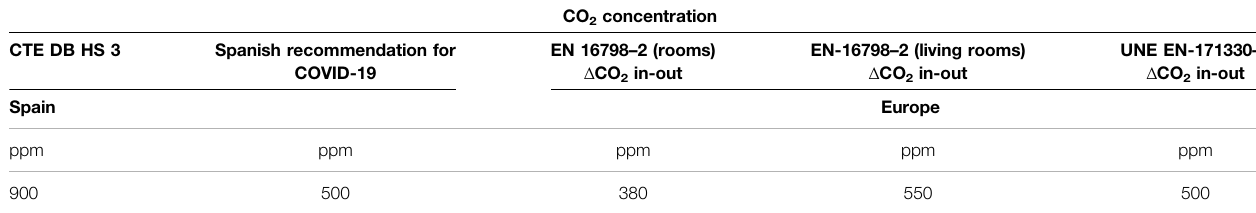
TABLE 8 | Comparison of CO 2 concentration results by the different